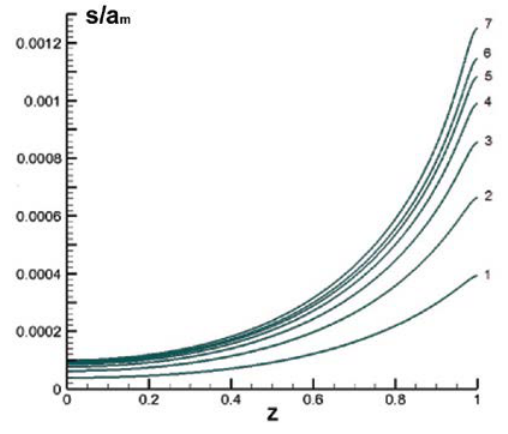
Fig. 1b. Vortex line evolution under the effect of subcritical current pulse, curves 1 – 7: t = 0.025, 0.050, 0.075, 0.100, 0.125, 0.150, 0.375.